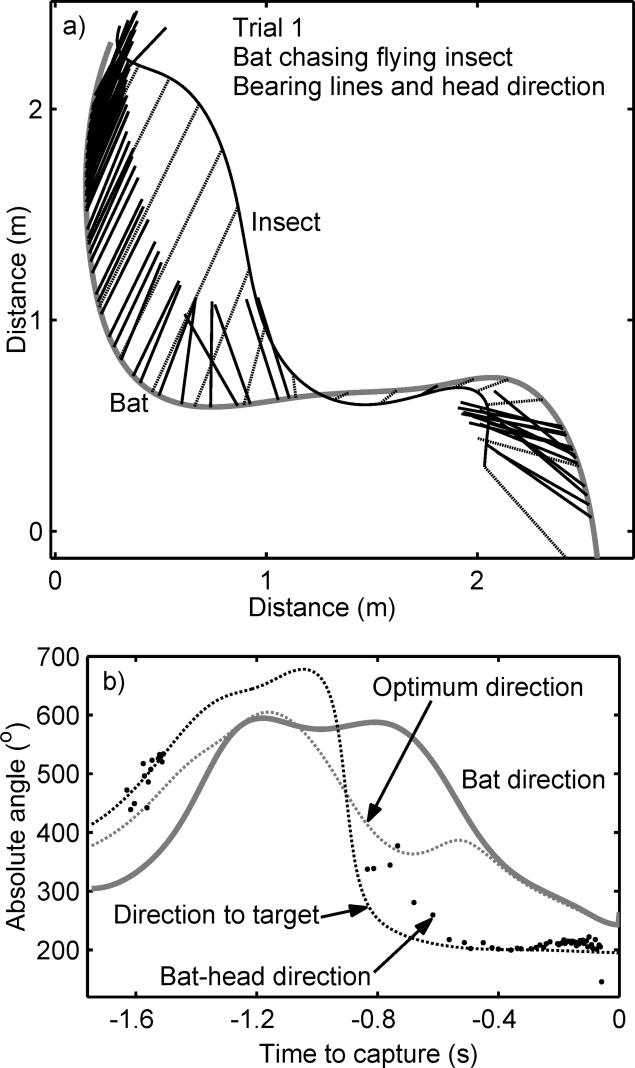
The Bat's Head Is Stabilized in Space during CATD because the Bat Locks Its Head onto the Target and Keeps the Absolute Direction of the Bearing Lines Constant(A) [Similar to
Figure 2A] Bat (gray curve) chases an erratically flying insect (black curve) capturing it at time
t = 0. Bearing lines (black dotted) are drawn from the bat to the target every 100 ms. The head-aim of the bat is computed and drawn (straight black line shooting from bat's flight track) each time it emits a vocalization.
(B) The bat's flight direction (thick grey line), the theoretically optimum direction (thin, dotted grey line), the direction to the target (black dotted line), and the bat's head direction (black dots) are shown. Visual inspection of (A) and the computations in graph (B) show that when the bat converges to the CATD strategy (i.e., matches its direction to the optimum direction by maneuvering to optimum bearing), its absolute head direction stabilizes, since it locks onto the target with its head. This can be seen dynamically in
Videos S1–
S4. We use this observation to suggest, in the discussion, a simple mechanism by which the bat can implement CATD (a functionally predictive strategy) without needing an internal model of target motion.